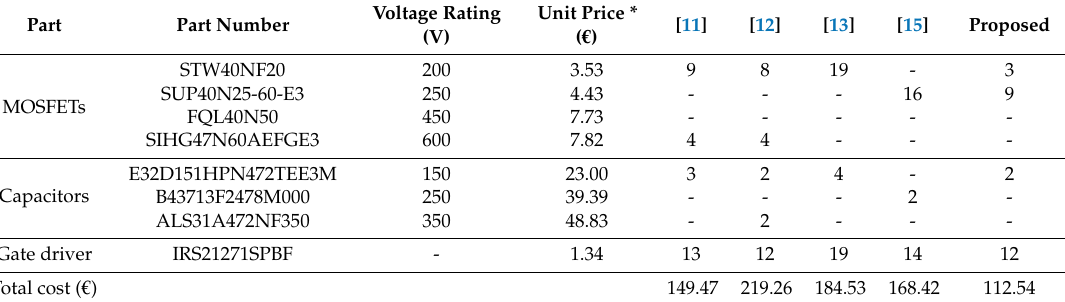
Table 2. Price Comparison of the Single-Source